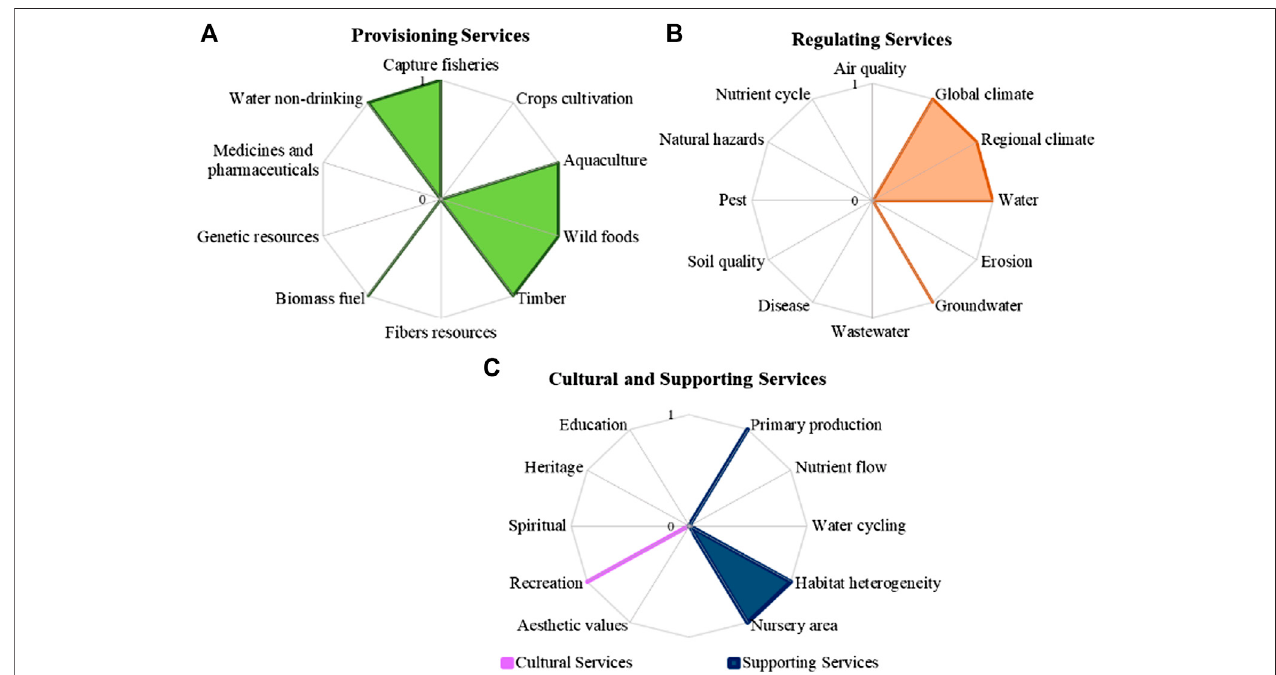
FIGURE 4 | Ecosystem Services quanti fi ed in African mangrove ecosystems (based on results from Table 3 ): (A) provisioning, (B) regulating, (C) cultural and supporting (0 – not quanti fi ed; 1 – quanti fi ed).